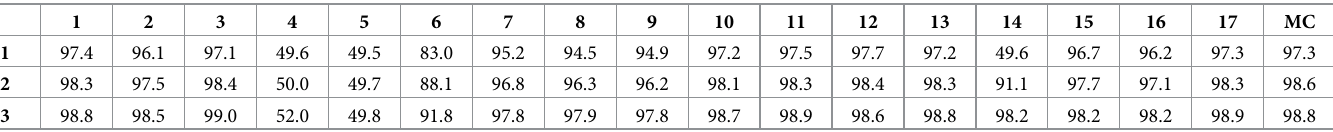
Table 4. Details of individual step assessment results. Q1 refers to the first quartile, Q2 to the median and Q3 to third quartile. The results are expressed as percentages.